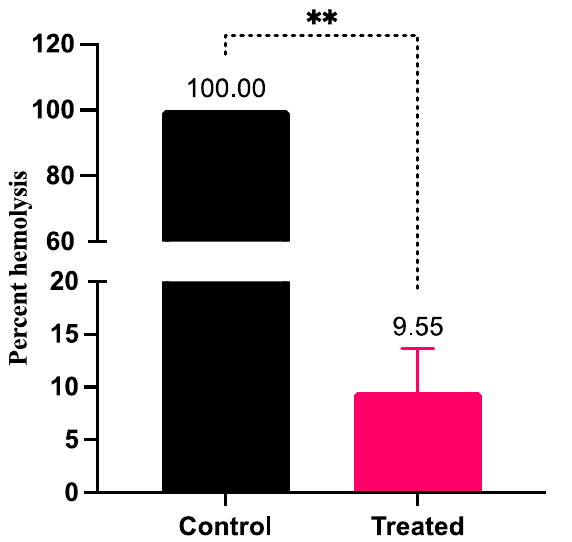
Figure 4. Effect of KAU007 on hemolytic property of S. pyogenes . The figure represents the impact of LME on percent streptococcal hemolysis ** p value = 0.001. 3.5. LME Abrogates the EPS Production and Cell Surface Hydropgobicity in S. pyogenes LME inhibted EPS production in S. pyogenes ; EPS was lowered to 32.5% compared to the untreated control (Figure 5A). Similarly, LME resulted in a reduction of cell surface hydrophobicity in S. pyogenes . The untreated control displayed 80.66% cell surface hydro- phobicity, whereas the LME-treated bacteria showed only 31.83% cell surface hydropho- bicity (Figure 5B). Figure 5. Effect of LME on EPS production and cell surface hydrophobicity (CSH). The figure demonstrates the modulation of EPS production (*** p value = 0.0005) and CSH (** p value = 0.0056) in the presence (treated) and absence (control) of LME.